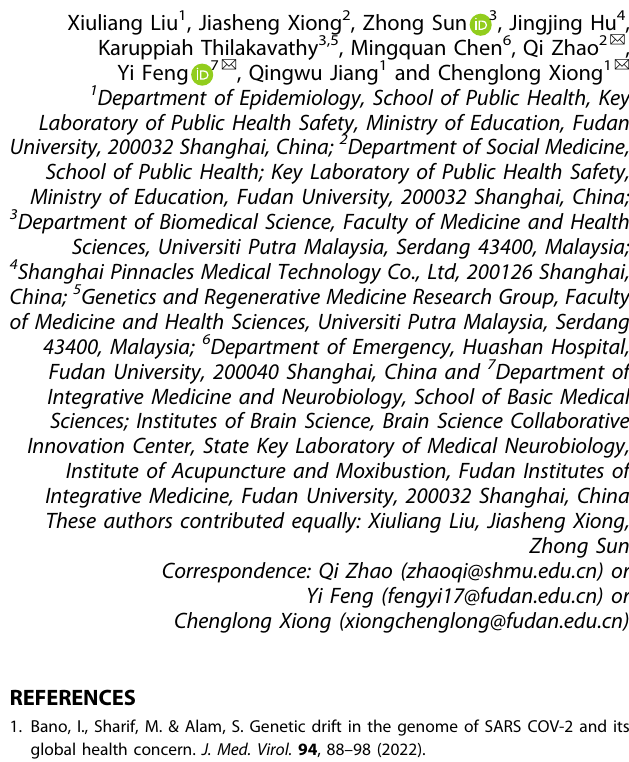
Fig. 1 Panel of information related to the recombination event. a Schematic overview of the recombination events. Three representative isolates of prototype Omicron variant (PANGO lineage B.1.1.529), OL920485, OL901845, and OL902308, were hybridized into a genomic fraction from the minor parent MW737421 at the same position (21593-23118 nt). This recombination event can be detected via fi ve statistical test methods, RDP ( P = 1.410 × 10 − 10 ), GENECONV ( P = 1.028 × 10 − 8 ), MaxChi ( P = 8.468 × 10 − 5 ), Chimaera ( P = 8.286 × 10 − 5 ), and 3Seq ( P